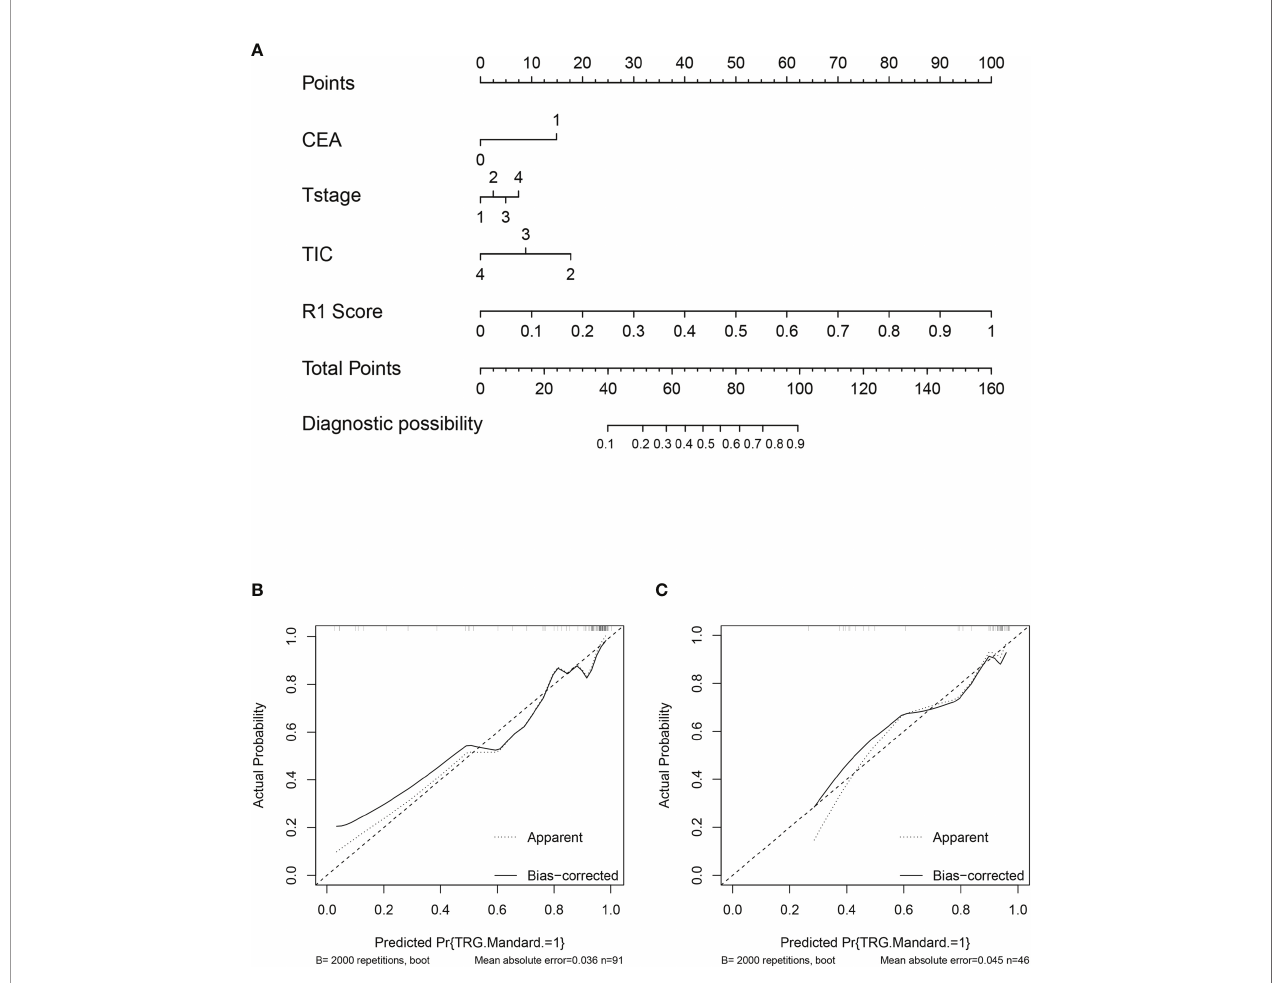
FIGURE 4 | Nomogram based on the clinical characteristics and peritumor radiomics features in the prediction of response to neoadjuvant chemotherapy in locally advanced rectal cancer (LARC). (A) Nomogram based on peritumor radiomics clinical features. (B) The calibration curve for peritumor radiomics and clinical features in predicting treatment response for LARC in the training set. (C) The calibration curve for peritumor radiomics and clinical features in predicting treatment response for LARC in the validation